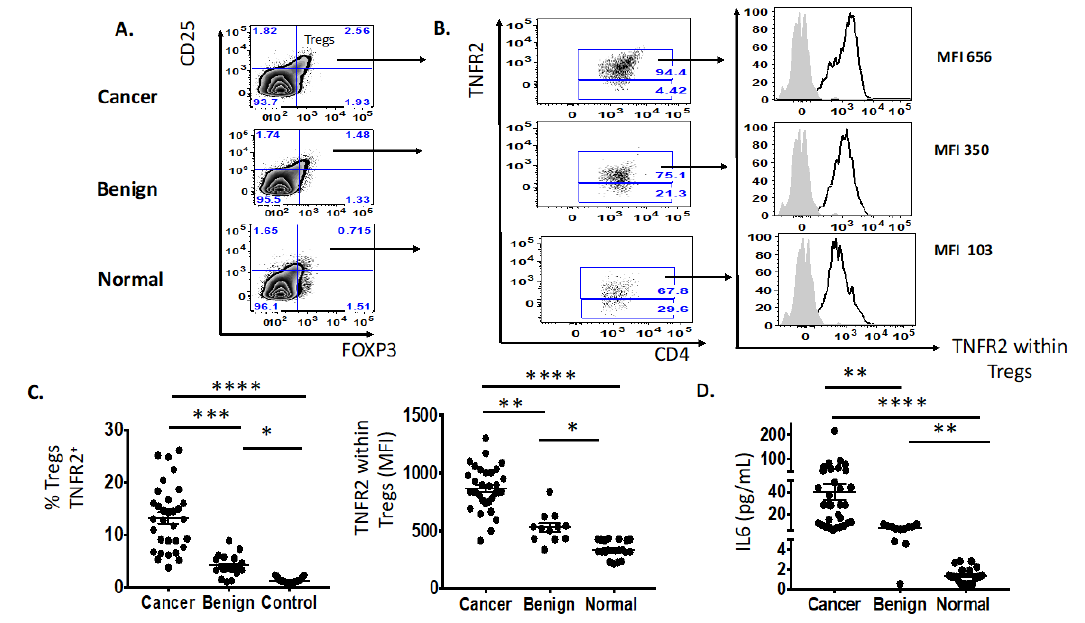
Figure 4. Increased proportion of Tregs TNFR2 + and IL-6 in the pre-treatment peripheral blood of patients with advanced HGSOC ( n = 33) compared to benign ( n = 12) and normal ovaries ( n = 21). ( A ) Flow cytometry plot of proportion of Tregs, CD25 hi FOXP3 + . ( B ) Flow cytometry plot of frequency (%) and expression (MFI, median fluorescence intensity) of TNFR2 + Tregs in advanced HGSOC patients ( n = 33) compared to those with benign ovarian masses ( n = 12) and normal ovaries. ( C ) The proportion of Tregs TNFR2 + (in colored font and top right-hand column with black arrow) and level of expression (MFI) of TNFR2-expressing Tregs between three study groups. ( D ) The level of IL-6 (pg/mL) in the serum between three study groups. One-way ANOVA and Dunn’s multiple comparison test (post hoc); * p < 0.05, ** p = 0.001–0.01, *** p = 0.0001–0.001, **** p < 0.0001 (error bars—SEM).